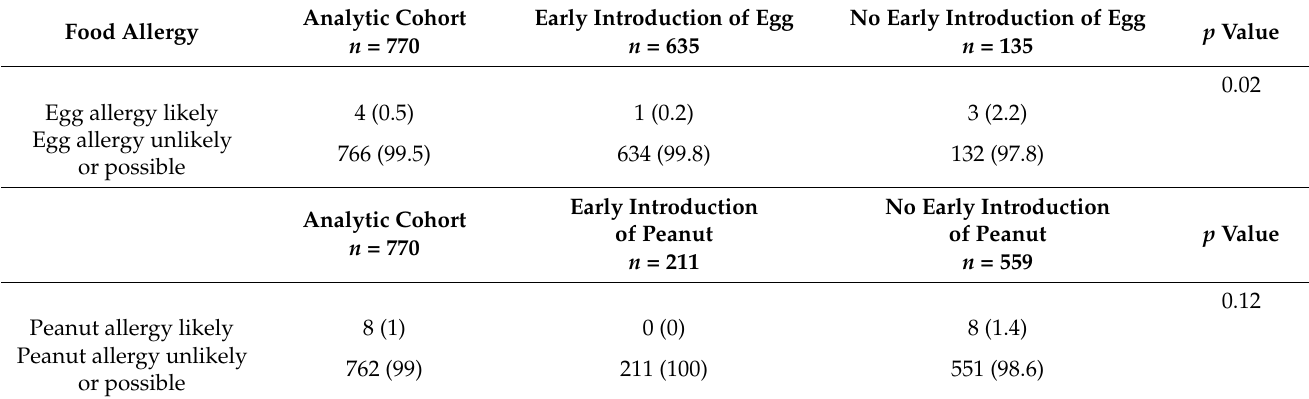
Table 2. Early introduction of egg or peanut at age 12 months and likely food allergy to egg or peanut by age 3 years. Food